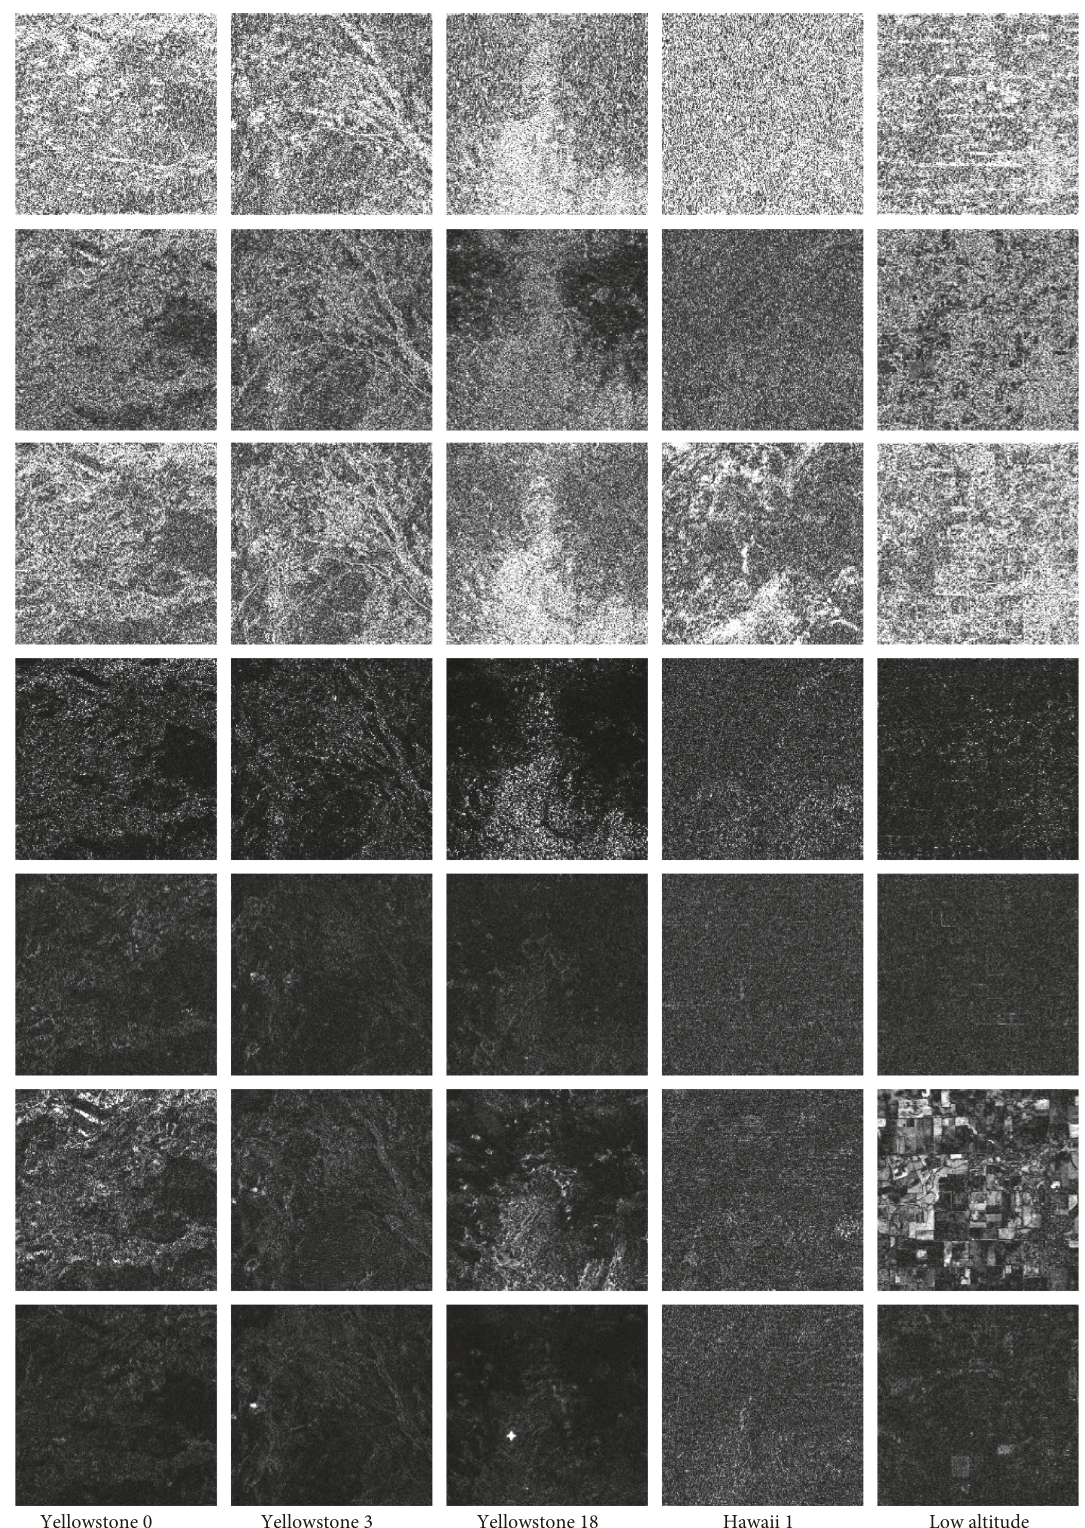
Figure 5: Residual images of band 30 under the 0.2 sampling rate of all competitive algorithms; from top to bottom: STNCS, JT-3DTV, E- 3DTV, HSSTV, DCHS, DCS_SLM, and